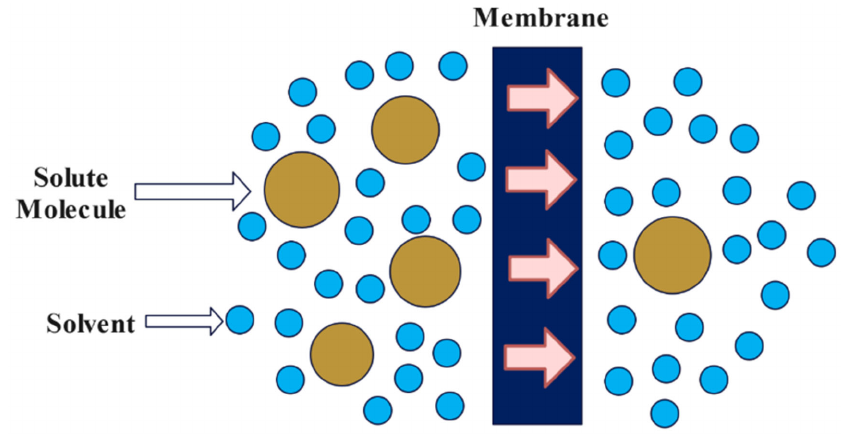
Figure 4. Membrane filtration technique [81].